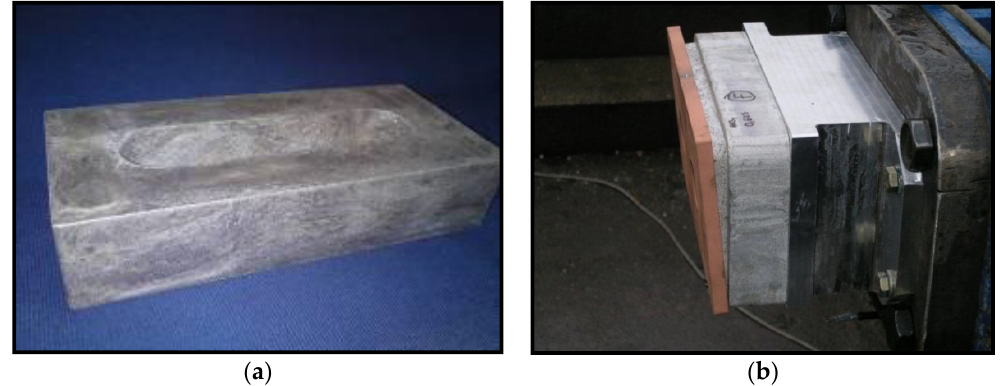
Figure 8. Crash absorbers ( a ) of the Combino tram in Budapest produced by Alulight; and ( b ) of the Sprinter Light Train in Holland produced by Gleich and SAS Bratislava (courtesy of Alulight, Gleich and SAS Bratislava).